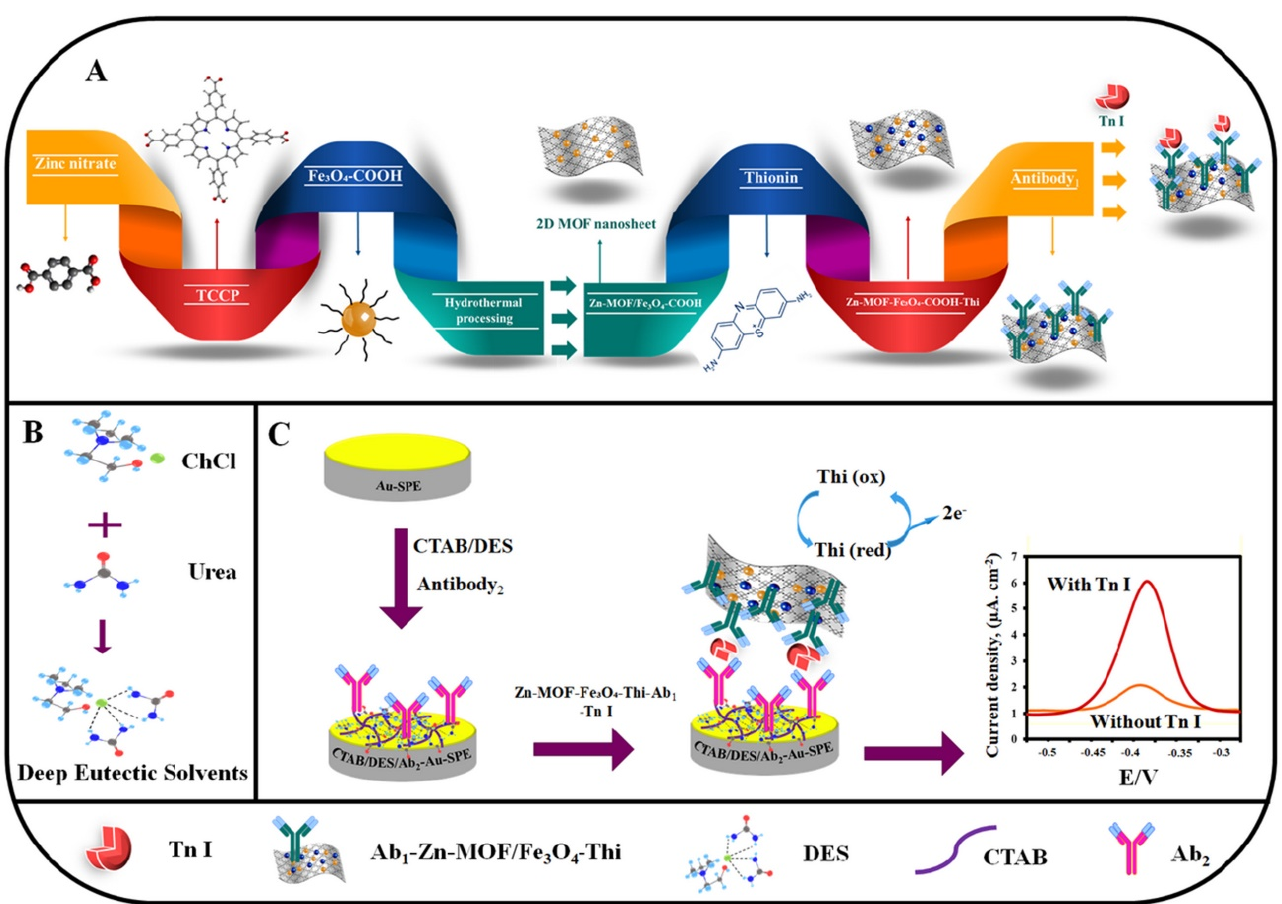
Figure 12. Schematic representation of ( A ) antibody labelled 2D Zn − TCPP MOF/Fe 3 O 4 − COOH/Thi. ( B ) Deep eutectic solvent, ( C ) electrochemical sensing mechanism of CTnI. Reprinted from [99], with permission from Elsevier.